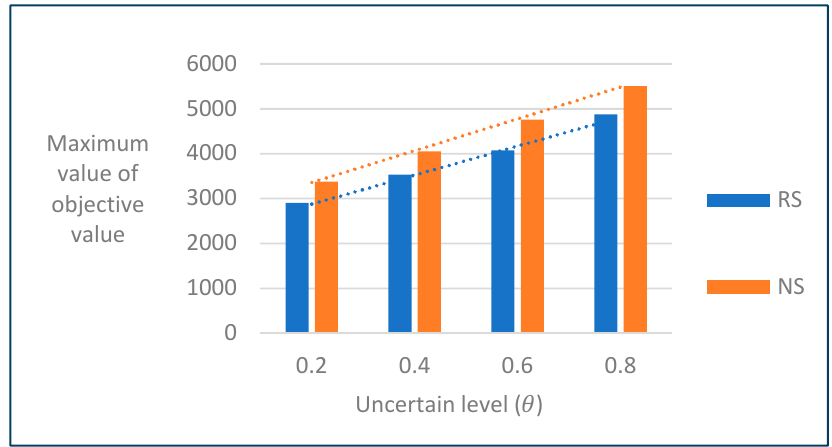
Figure 3. The maximum value of the objective value among 150,000 simulation results for each given uncertain level value (n = 15).